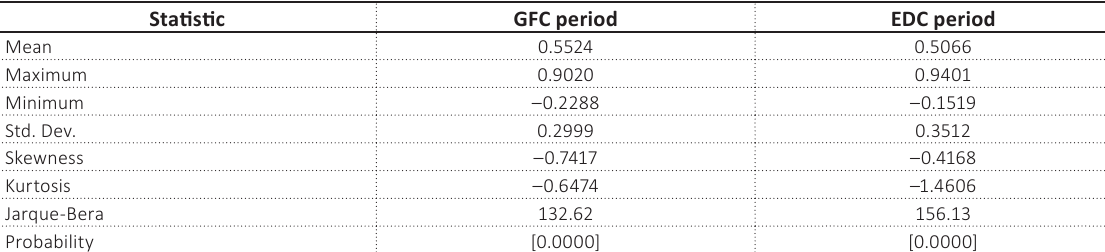
Table 4. Descriptive statistics for